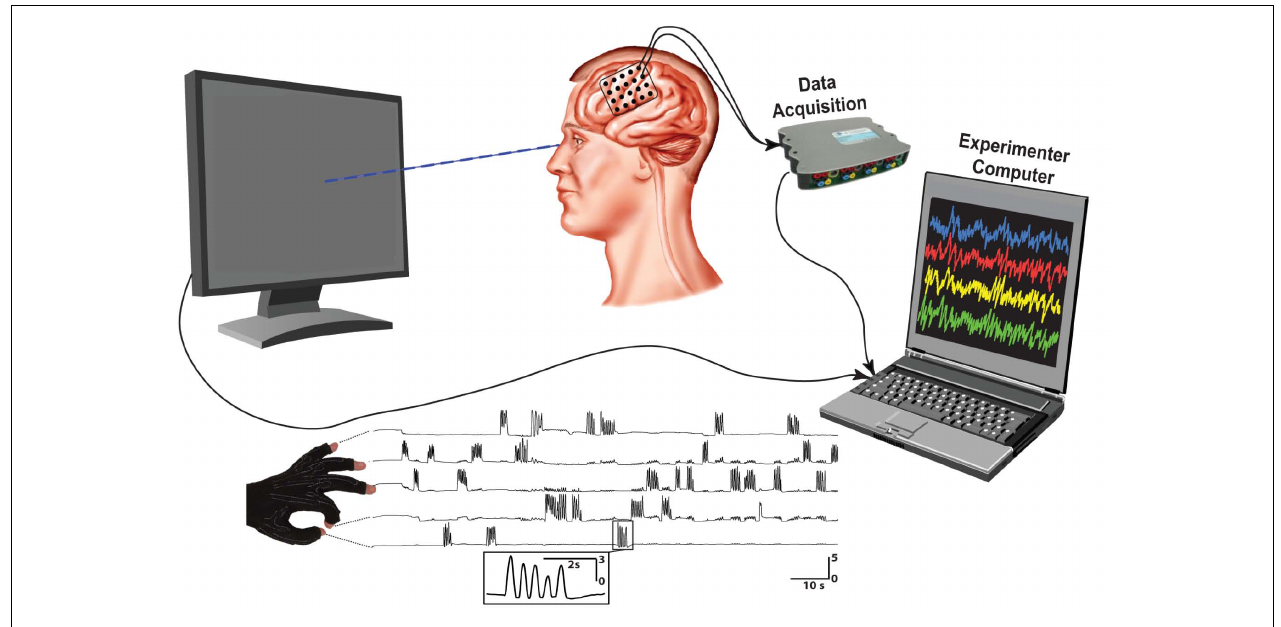
FIGURE 1 | Experimental setup for this